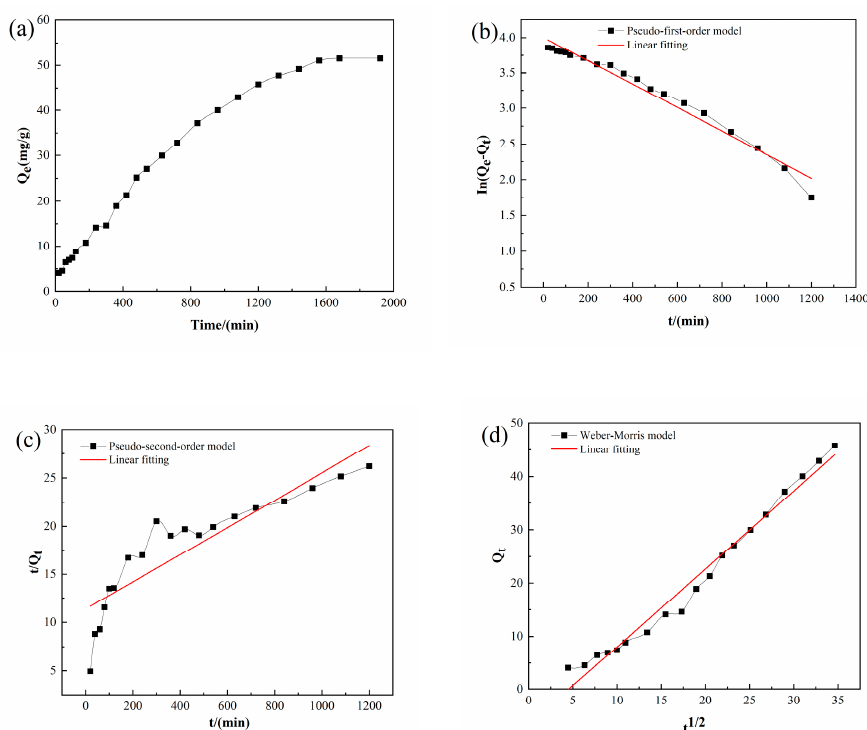
Figure 12. Relationship between adsorption capacity and time ( a ), fitting curve of pseudo-first order model ( b ), fitting curve of pseudo-second order model ( c ), fitting curve of Weber–Morris model ( d ).